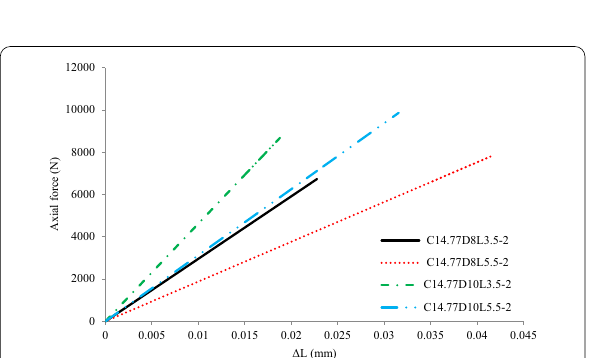
Fig. 10 Sliding force–deformation diagram in C14.77D8L3.5T0-2 and C14.77D8L5.5-2, and C14.77D10L3.5-2 specimens. AE K = . l e